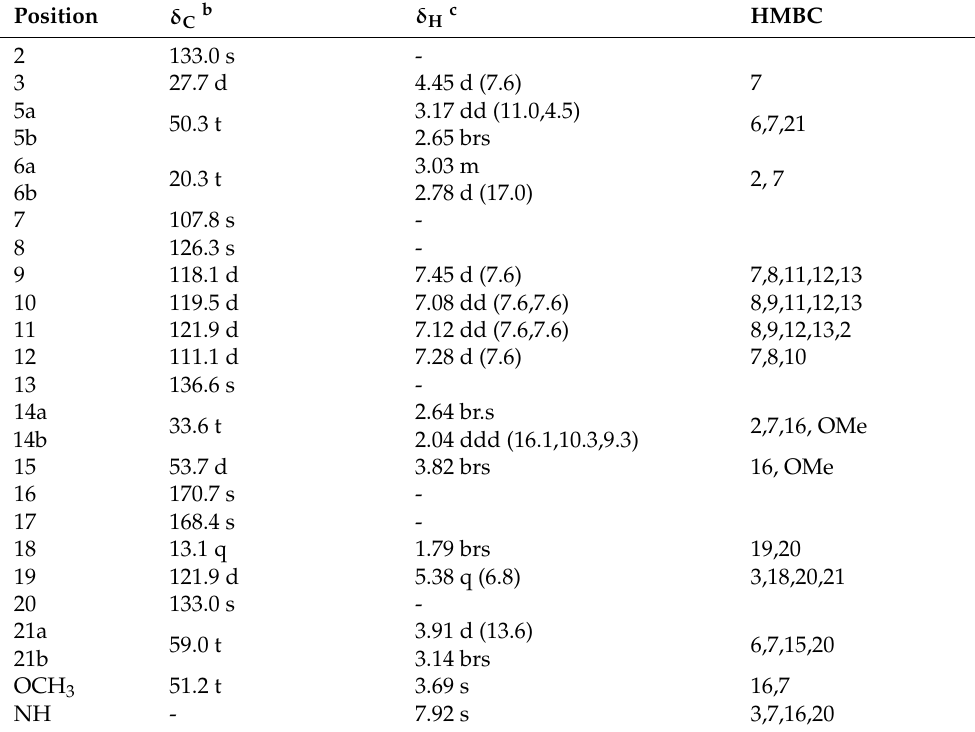
Table 2. 1 H, 13 C-NMR, and HMBC of compound 2 a